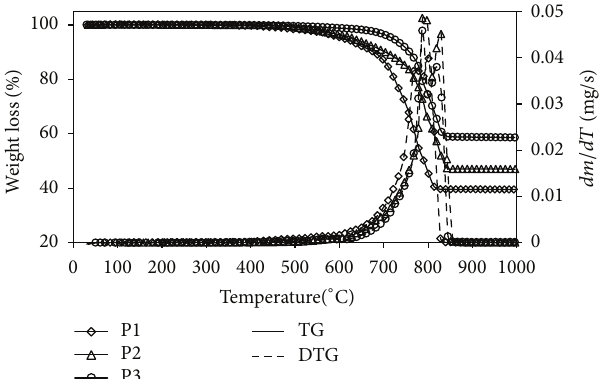
Figure 2: TG and DTG curves of Malaysian